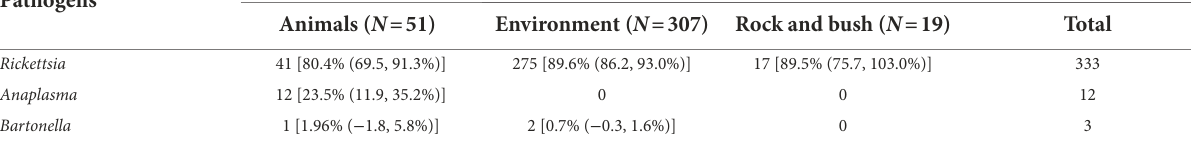
TABLE 2 Pool positivity rate by collection source [% and (95% CI)].